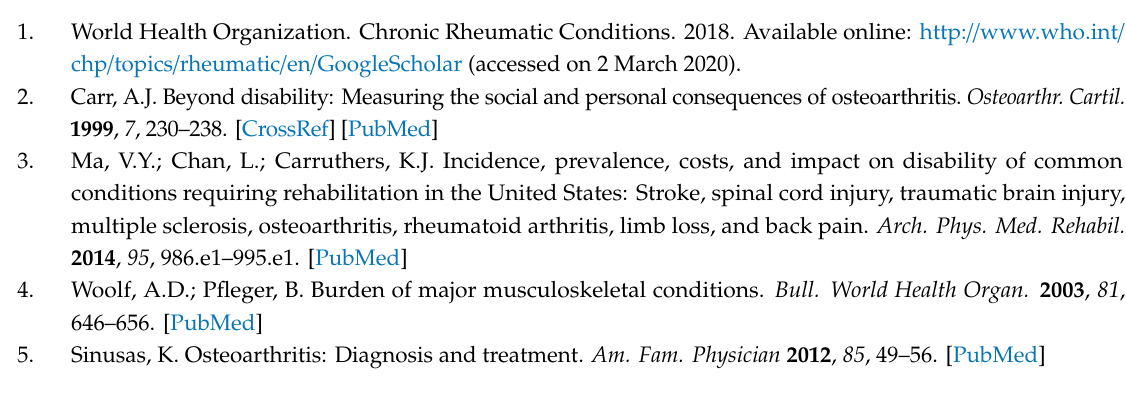
Figure S1: System of molecules 14G1862, freeze-dried extract UHPLC-qToF fingerprint Total Ion Current_ Negative ions. b. System of molecules 14G1862 freeze-dried extract UHPLC-qToF fingerprint_Total Ion Current_ Positive ions. c. System of molecules 14G1862 freeze-dried extract GC-QqQ (HS) fingerprint Total ion Current_ MRM Mode. d. System of molecules 14G1862 freeze-dried extract ICP-MS fingerprint _Total Ion Current. e. System of molecules 14G1862 freeze-dried extractIC-CD_Anions